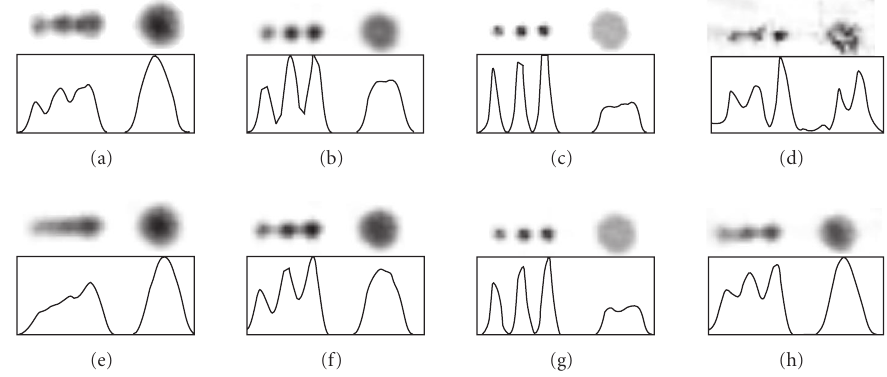
Figure 4: Simulation with a computed phantom composed of three small spots and a bigger structure. (a)–(d) show results obtained with the FA-SART algorithm, ρ = 1, and (e)–(h) show results with the SART algorithm (which is FA-SART with ρ = 0). The pinhole aperture was 2.5 mm for (a) and (e), 1.5 mm for (b) and (f), 0.025 mm for (c) and (g), and 1.5 mm with noise added onto the projections for (d) and (h). These results show improvements with FA-SART when the PSF is large (2.5mm and 1.5mm) and better images with SART when the data are noisy (Gaussian noise, 20% of the maximum of the data), especially for big structures. No significant di ff erence is visible when the PSF is small, because the stage of deconvolution is of less importance during the reconstruction